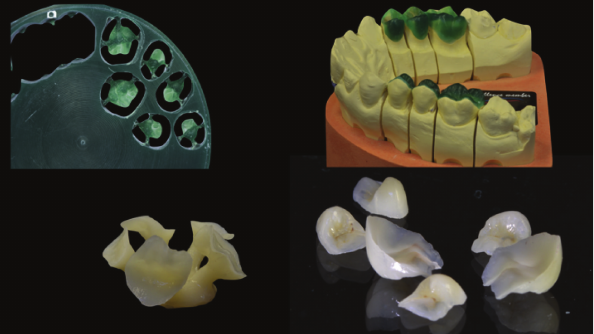
Figure 3: Case 1 (Monolithic Lithium Disilicate Onlays). The wax patterns of the posterior onlays were milled out of a wax disk (Cera SDD98A18RWC, Sintesi Sud, Avellino, Italy) using a Roland DWX- 50 Dental Milling Machine (Whip Mix GmbH, Louisville, KY, USA) andthenrepositionedonthecast.Aftercarefulchecking,thelithium disilicate heat pressed onlays (IPS e.max Press MT, Ivoclar Vivadent) were made and eventually